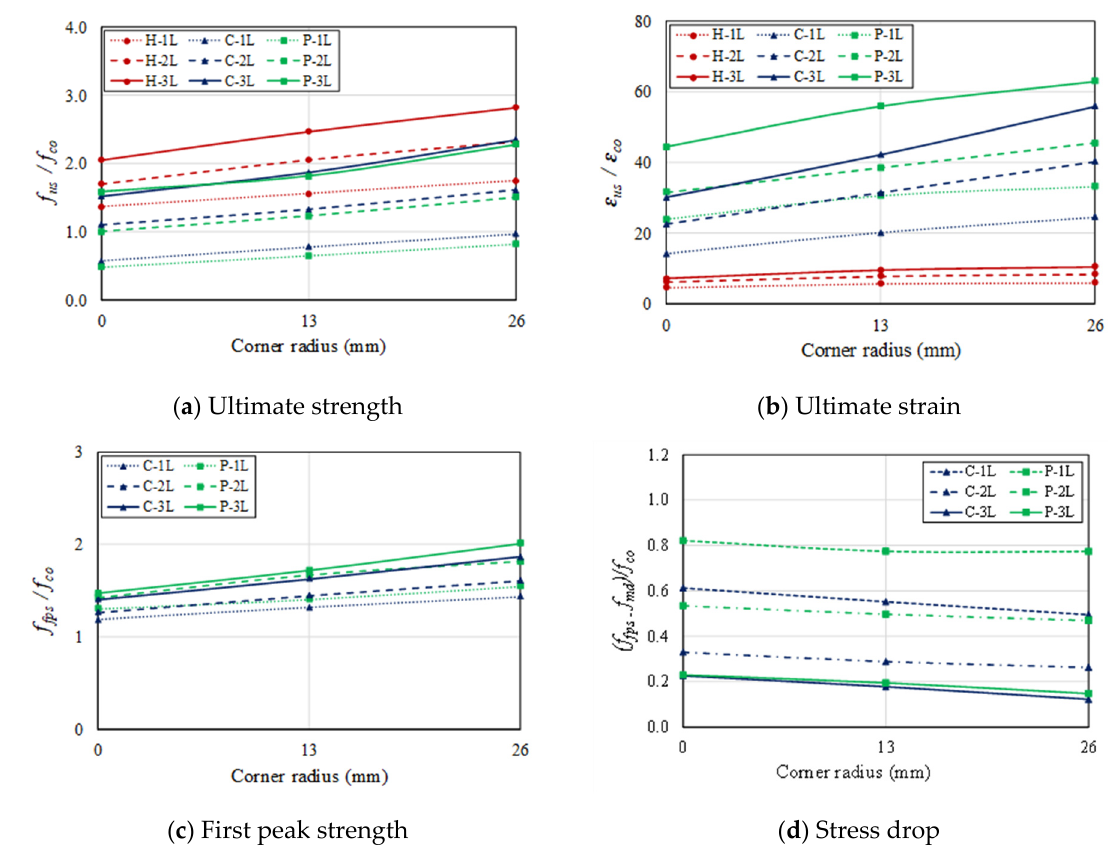
Figure 10. Effect of corner radius (H = hemp FRRP, C = cotton FRRP, P = polyester FRRP, 1L = 1 layer of FRRP, 2L = 2 layers of FRRP, 3L = 3 layers of FRRP).